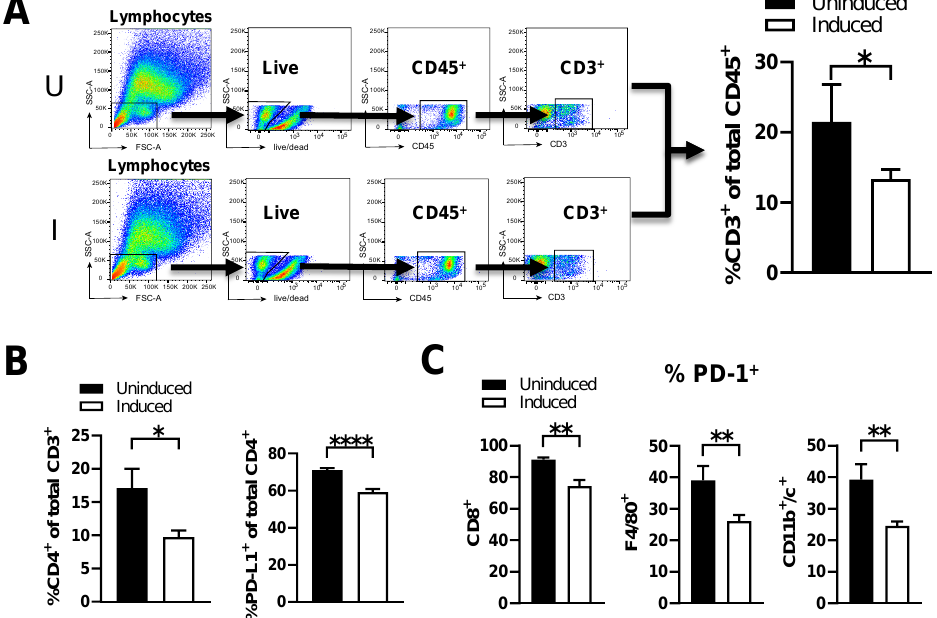
Figure 4. ST-SOT treatment reduces intratumoral frequency of suppressive immune subsets. Pan02 tumor-bearing mice were treated with ST-SOT under inducing conditions (I) or uninduced (U). Forty-eight hours later, mice were euthanized and tumor homogenates were subjected to flow cytometry to evaluate intratumoral immune phenotypes. ( A ) Initial gating strategy on CD3 + cells in tumors from uninduced and induced treatment groups ( n = 5). Additional analyses of CD3 + immune subsets were performed to quantify frequency of ( B ) CD4 + and PD-L1 + CD4 + cells. ( C ) Percent of PD-1 + immune subsets was determined for CD8 + T cells, macrophages (F4/80 + ), and dendritic cells (CD11b + CD11c + ). * p < 0.05, ** p < 0.01, **** p < 0.0001, t -test. Experiments performed ≥ 2 times.